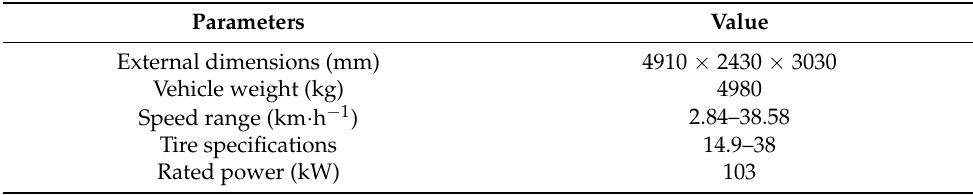
Table 2. The specifications of the tractor in the